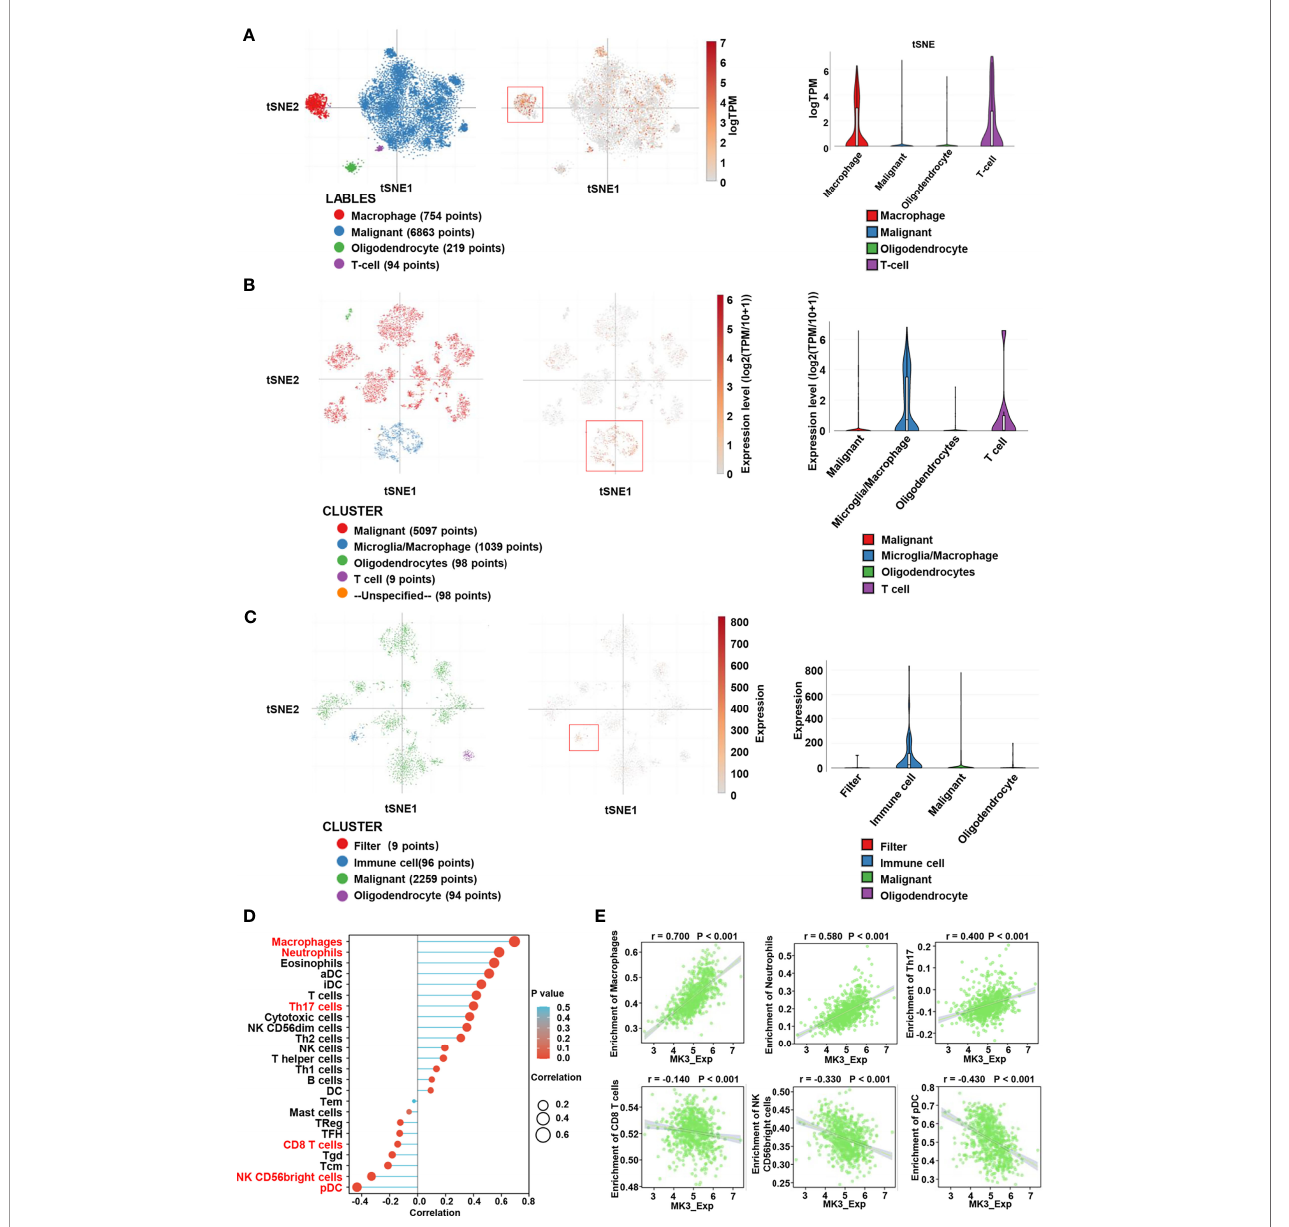
FIGURE 6 | Correlation between MK3 and immune cell in fi ltration. (A) Classi fi cation of single cells and the distribution of MK3 in glioblastomas. Left: t-distribution stochastic neighbor embedding (tSNE) plot of all single cells. Cells are labeled based on the high expression of sets of marker genes for macrophage (red), malignant (blue), oligodendrocyte (green), and T cells (purple). Medium: tSNE plot of MK3 speci fi c expression cells (red). Right: violin plot of the distribution of MK3 . (B) Classi fi cation of single cells and the distribution of MK3 in tumor samples of IDH-mutant astrocytoma. Left: tSNE plot of all single cells. Cells are labeled based on the basis of high expression of sets of marker genes for malignant (red), microglia/macrophage (blue), oligodendrocyte (green), T cells (purple), and unspeci fi ed (yellow). Medium: tSNE plot of MK3 speci fi c expression cells (red). Right: violin plot of the distribution of MK3 . (C) Classi fi cation of single cells and the distribution of MK3 in gliomas with histone H3 lysine27-to-methionine mutations. Left: t-distribution stochastic neighbor embedding (tSNE) plot of all single cells. Cells are labeled based on the high expression of sets of marker genes for fi lter (red), immune cell (blue), malignant (green), and oligodendrocyte (purple). Medium: tSNE plot of MK3 speci fi c expression cells (red). Right: violin plot of the distribution of MK3 . (D) Lollipop plots showing the correlation between the MK3 expression level and the relative abundances of 24 immune cells in GBM and LGG samples from TCGA dataset. The size of dots shows the absolute value of Spearman ’ s R. (E) The correlation analysis between the expression of MK3 and enrichment of immune cells (macrophages, neutrophils, Th17 cells, CD8 T cells, NK CD56bright cells, and plasmacytoid DC) in GBM and LGG samples from TCGA dataset. GBM, glioblastoma; LGG, low-grade glioma; TCGA, The Cancer Genome Atlas; DC, dendritic